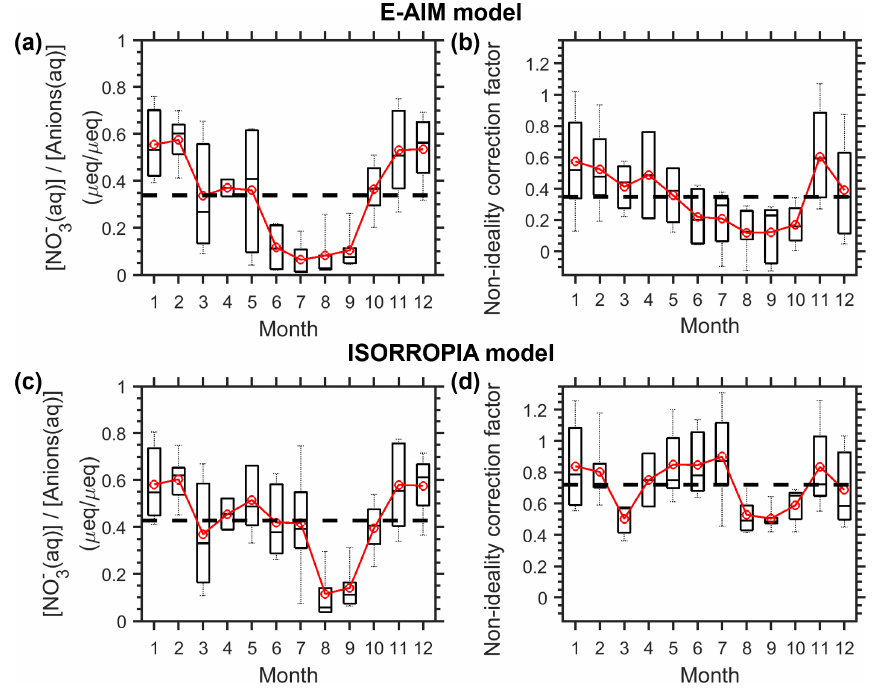
Figure E1. Monthly variation in (a, c) NO 3 - fraction in anions(aq) and (b, d) the corresponding non-ideality correction factors for the Toronto site in 2012. The data are estimated by (a–b) the E-AIM model and (c–d) the ISORROPIA model. The black dash lines represent the annual mean levels. The box and whiskers represent the 10th, 25th, 50th, 75th and 90th percentiles, while the red markers represent the monthly